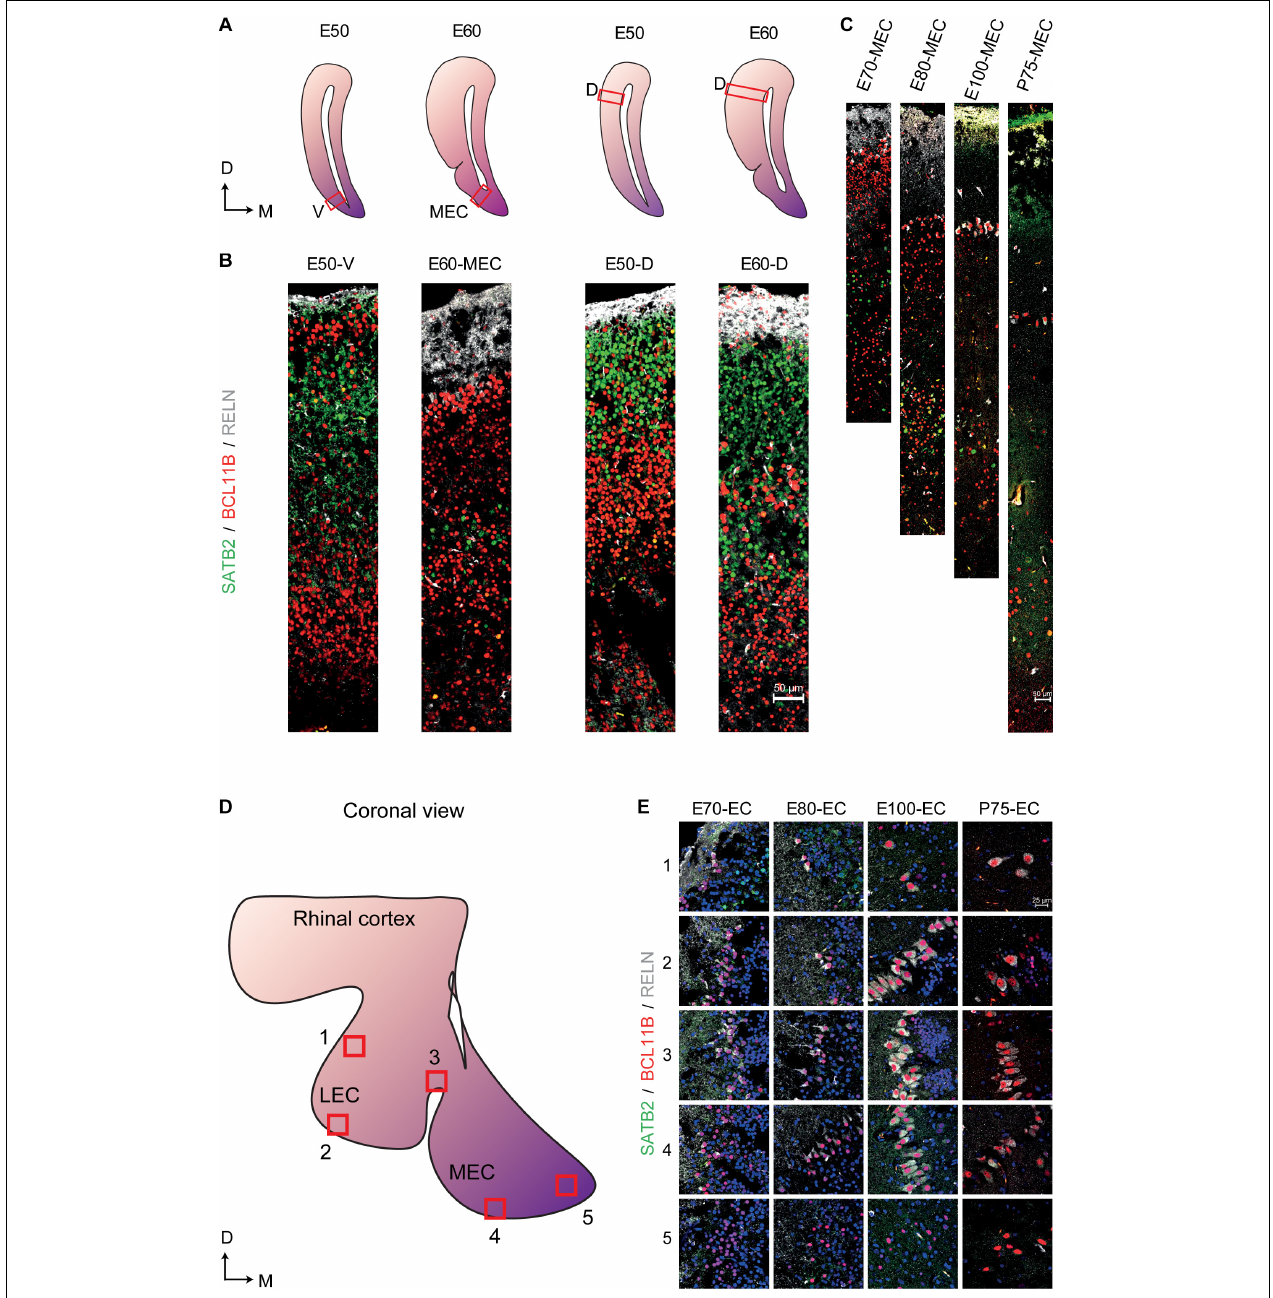
FIGURE 6 | Altered expression of superficial and deep layer markers in the entorhinal cortex (EC) persist even after birth. (A) Locations of the analyzed ventral telencephalon (V), the medial entorhinal cortex (MEC), and the dorsal telencephalon (D) at Embryonic day (E)50 and E60 of development (red boxes). D, Dorsal, M, Medial (B) Expression of SATB2, BCL11B, and RELN in the E50 ventral telencephalon the E60 MEC and the dorsal telencephalon at E50 and E60 shows a prominent expression of BCL11B in the superficial layer at E50 and the emergence of a new BCL11B population beneath the BCL11B + LII in the MEC at E60. (C) Expression of SATB2, BCL11B, and RELN in the MEC from E70 until Postnatal day (P)75 of development shows persistent expression of BCL11B + cells in the superficial layers. (D) Locations of analyzed superficial layers across the MEC and LEC from E70 to P75. (E) RELN + neurons co-express BCL11B across the EC during gestation and also after birth. Scale bar 50 µ m (B,C) and 25 µ m (E) .